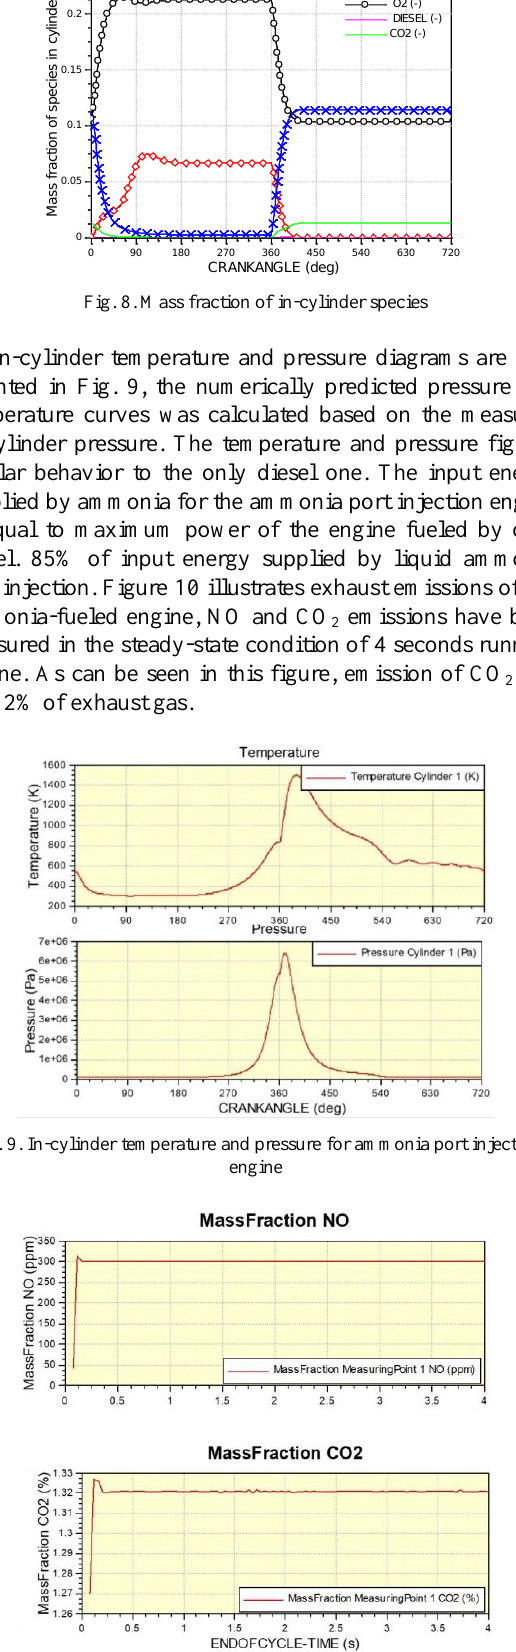
Fig. 10. Exhaust emissions of ammonia port injection in AVL